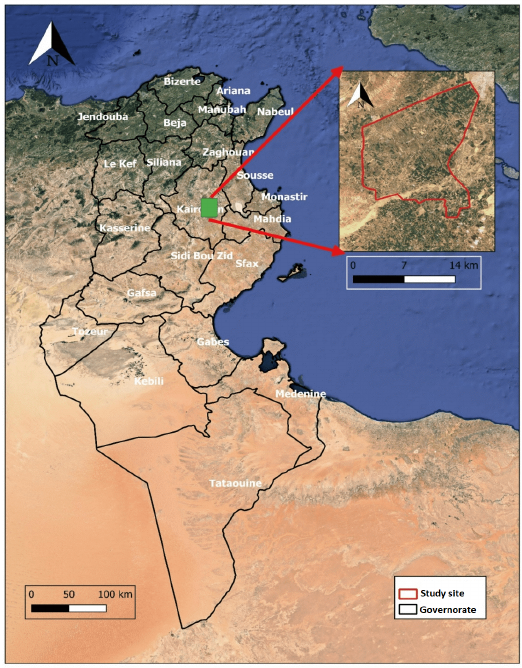
Figure 4. Extent of the study area - Kairouan - Central